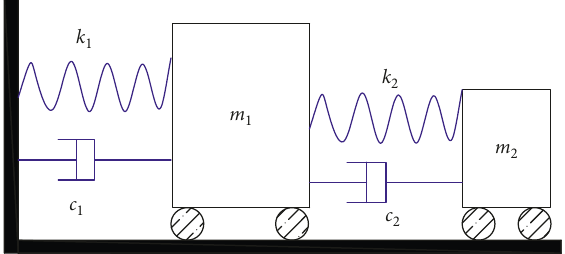
Figure 1: SDOF structure equipped with a